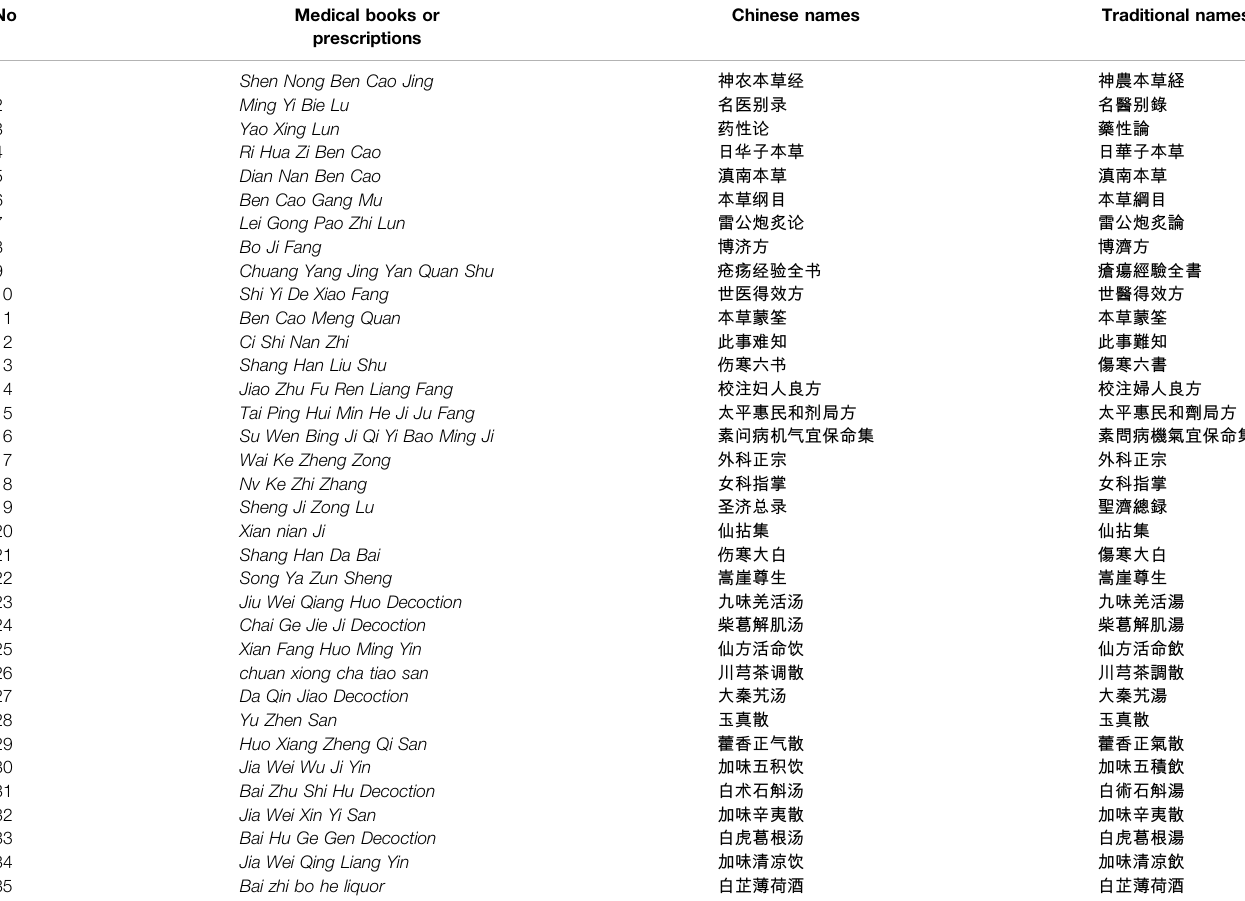
TABLE 3 | The Chinese names of the medical books and